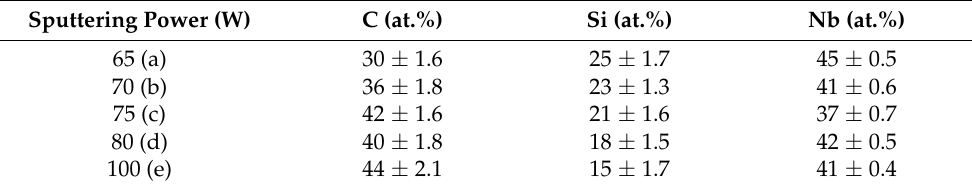
Table 3. EDS composition analysis results of the thin films (from a to